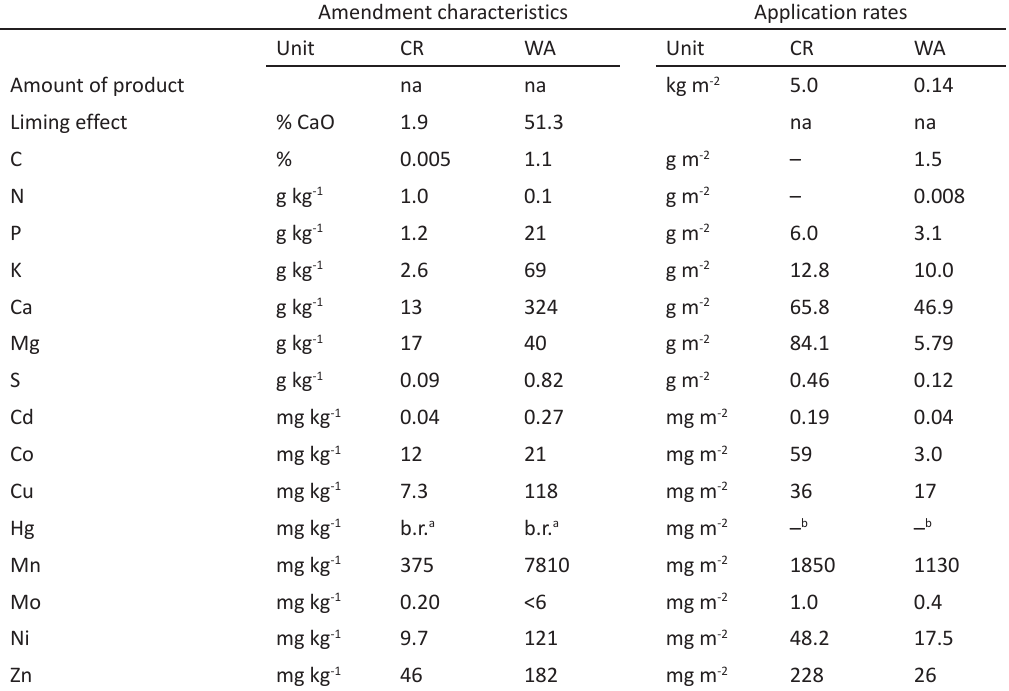
Table 2. Characteristics of the crushed rock (CR) and wood ash (WA), and product and nutrient application rates used in the experiment. The particle size distribution of the crushed rock was <2 μm 2%; 2–6 μm 2%; 6–20 μm 5%; 20– 60 μm 7%; 60–200 μm 10%; 200–600 μm 14%; 600–2000 μm 30%; >2000 μm 30%. Its mineralogy was dominated by plagioclase (60%), followed by clay minerals (sum 15%), K-feldspar (7.5%), quartz (6.7%) and pyroxene (6.6%) (Ramezanian et al.